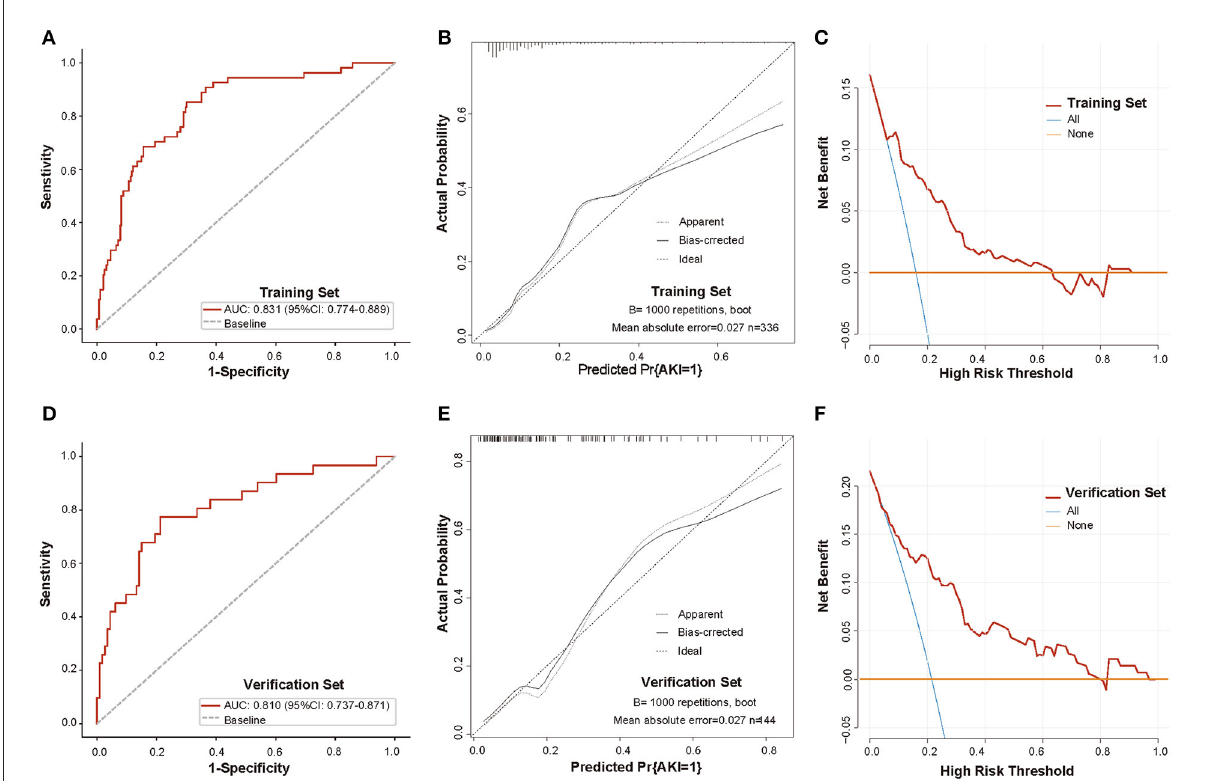
FIGURE5 Validation of the discrimination power of the nomogram in the training and validation sets. (A,D) ROC curve analysis of the nomogram in the training and validation sets (AUC, 0.831 and 0.810, respectively); (B,E) Calibration plot of the nomogram in the training and validation sets, The black dashed diagonal line indicates the perfect prediction of the ideal model. The solid black line represents the performance of the nomogram, and the closer the fit to the diagonal line, the more accurate the prediction. The gray dashed line represents the performance of the model trained after bootstrapping validation (1,000 bootstrap resamples), which corrects the overfitting situation; (C,F) DCA analysis of the nomogram in the training and validation sets. The y-axis represents the net benefit, the x-axis represents the threshold probability. The red line represents the nomogram, and the blue and orange lines represent the all-patient treatment scenario and the no-patient treatment scenario, respectively. Abbreviations: ROC, receiver operating characteristic; AUC, area under the curve; DCA, decision curve